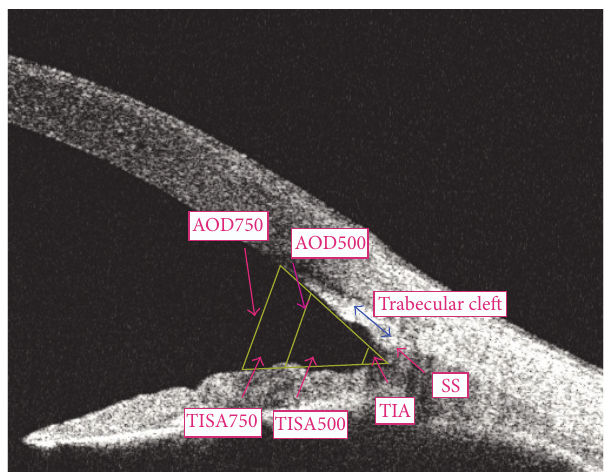
Figure 1: A cross-sectional OCT image of the nasal angle showing the anterior chamber angle parameters of a patient in combined Trabectome group